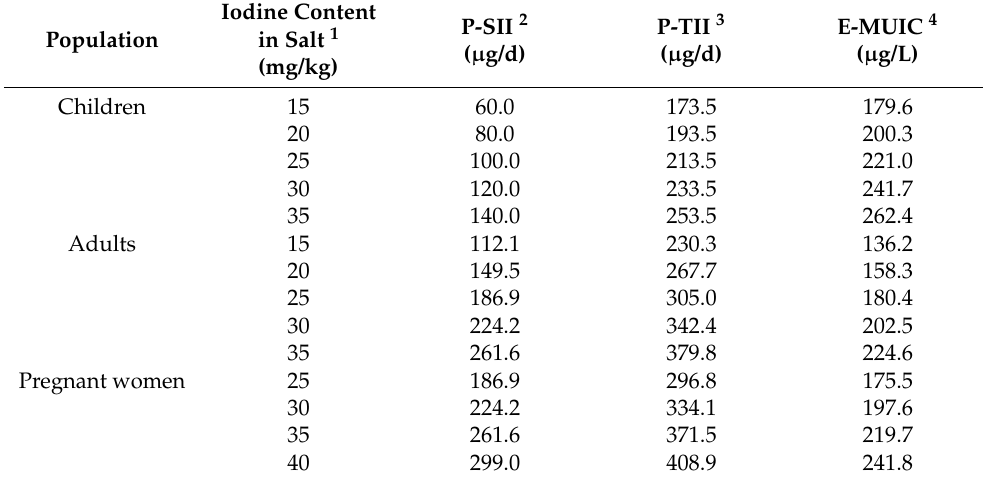
Table 3. Estimated iodine intake and urine iodine levels after changes in salt iodine content in China.